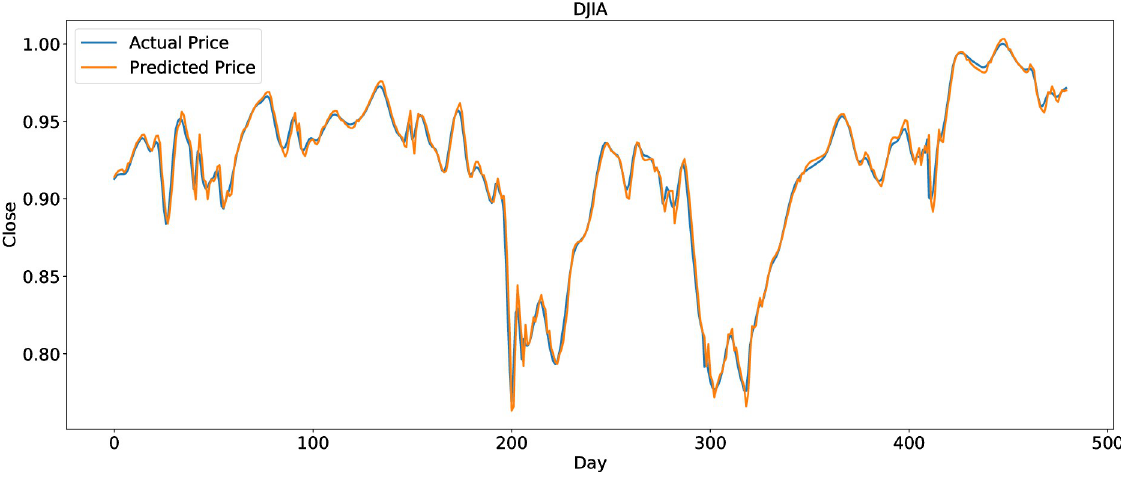
Fig 12. Prediction results of DJIA data set.